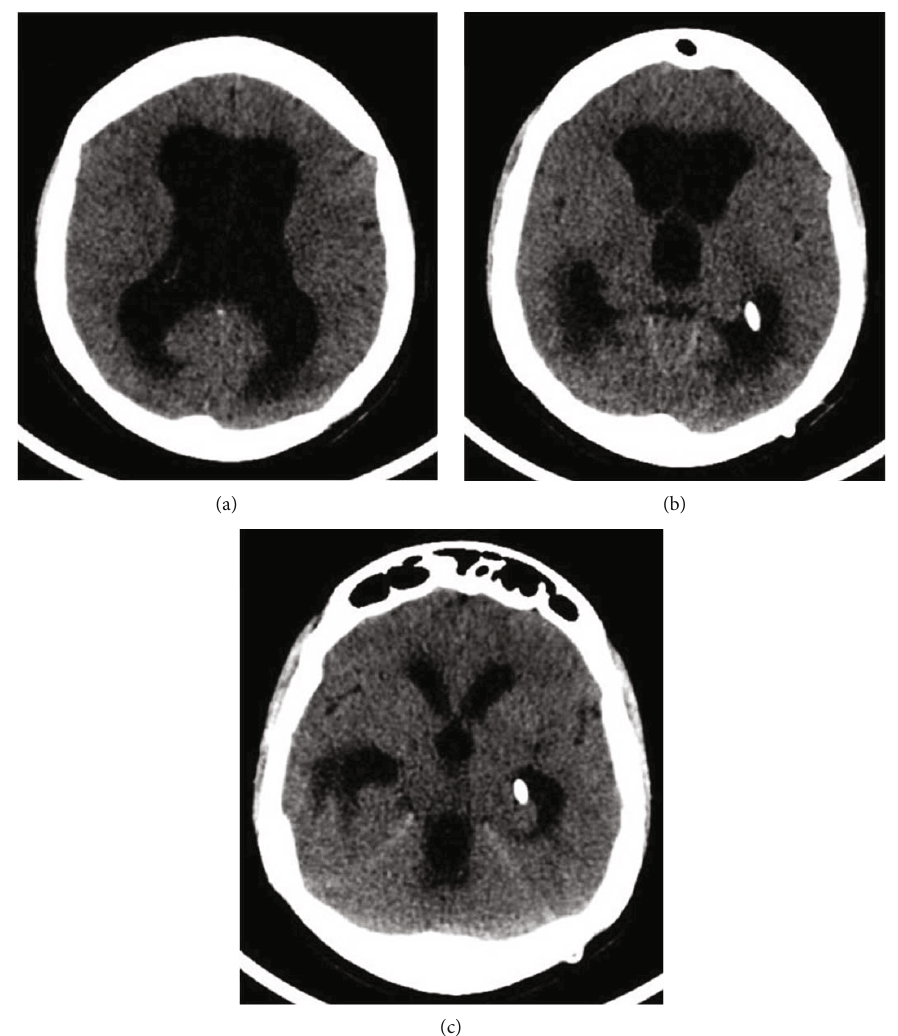
Figure 1: Preoperative cranial CT. (a – c) Axial slices demonstrate ventriculomegaly, enlargement of the temporal horns, and transependymal edema suggesting VPS obstruction. The ventricular catheter is positioned inside the temporal